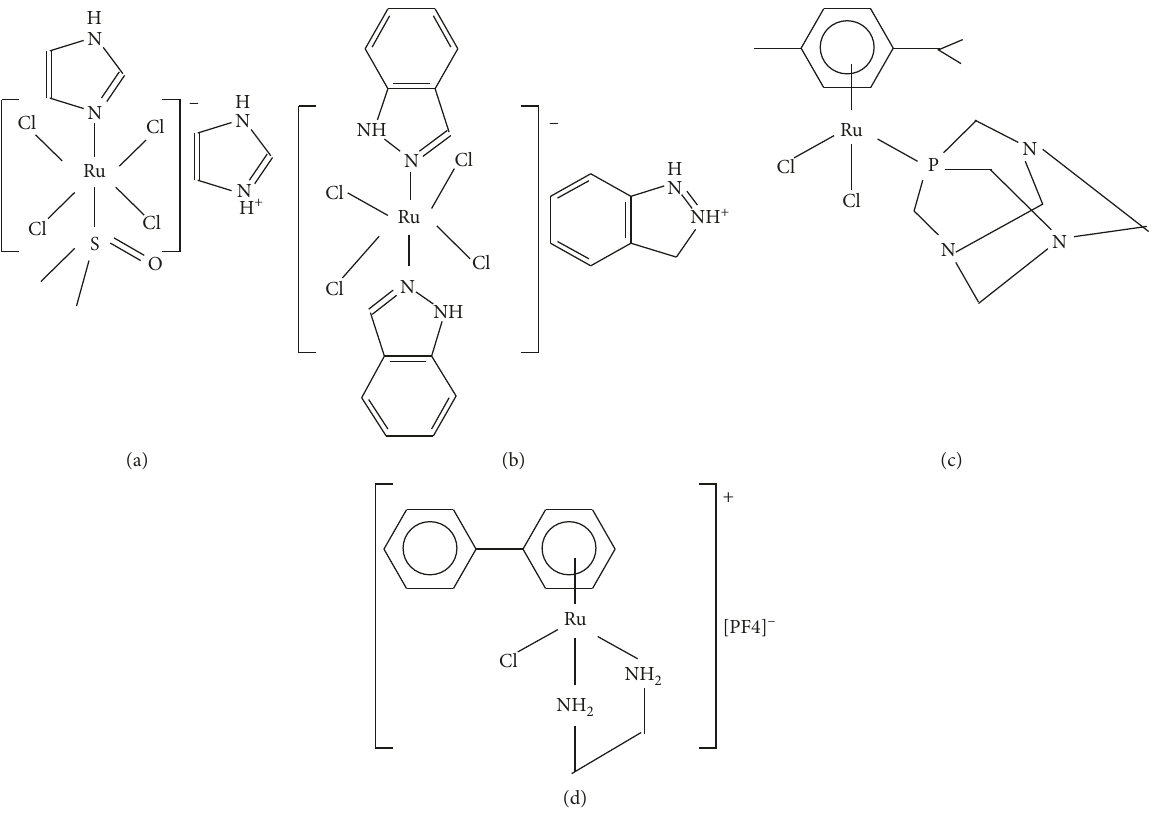
Figure 14: (a, b) Examples of ruthenium complexes and organometallic arene piano-stool ruthenium agents of Dyson; antimetastatic (c) RAPTA and (d) RAPTA-C complex. (a) NAMI-A, (b) KP 1019, (c) RAPTA, and (d)